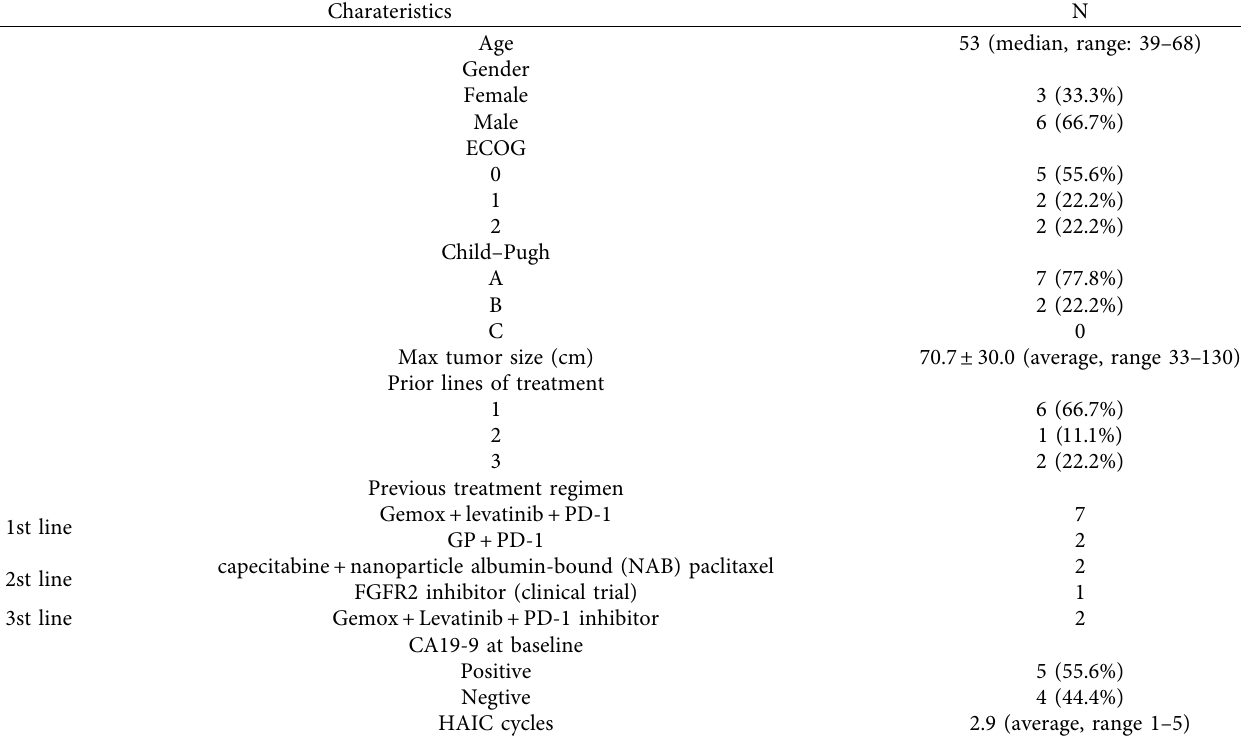
Table 1: The summary of patient